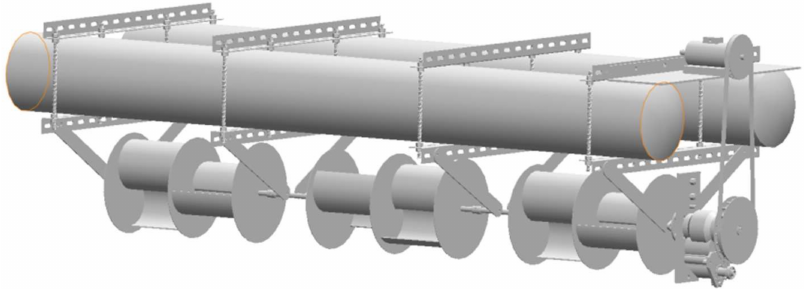
Figure 9. Key geometric parameters of breakwater.